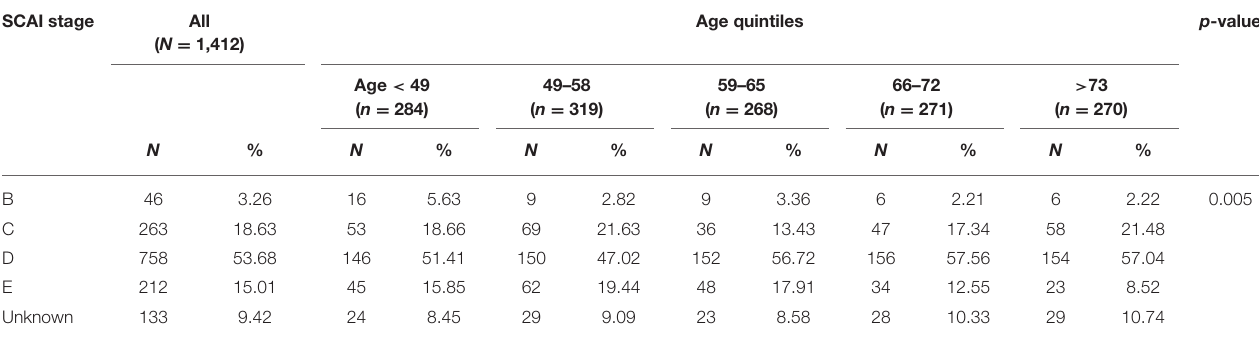
TABLE 2 | Distribution of SCAI stages across age quintiles. SCAI